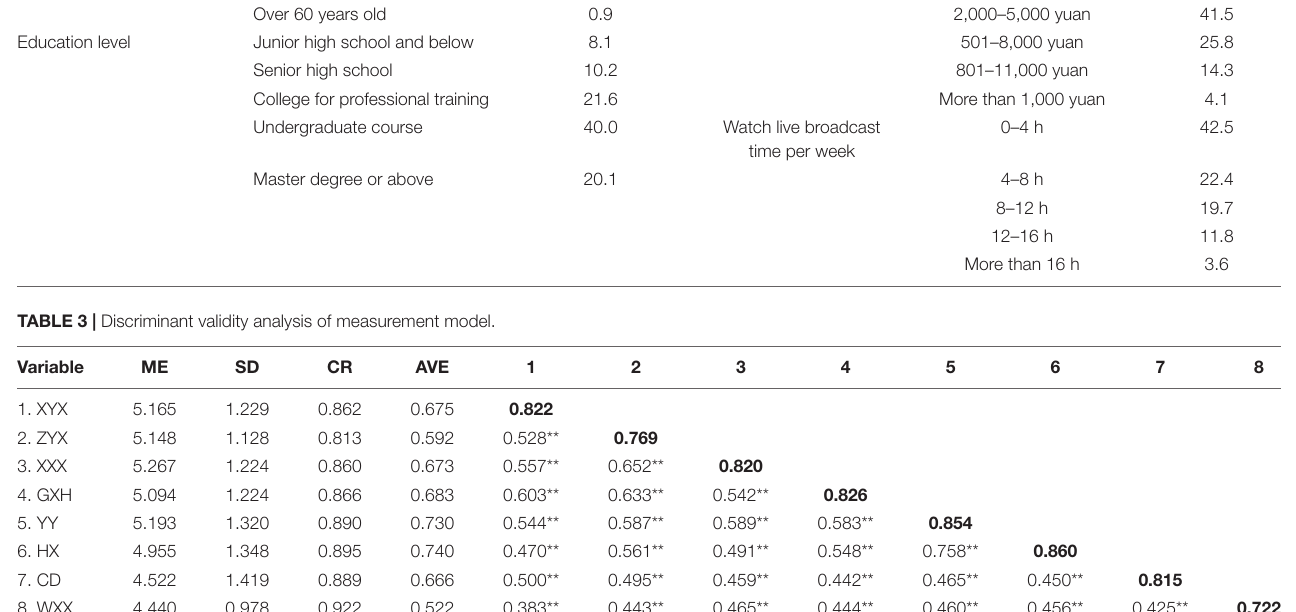
Table 3 : the CR was greater than 0.7, indicating that each